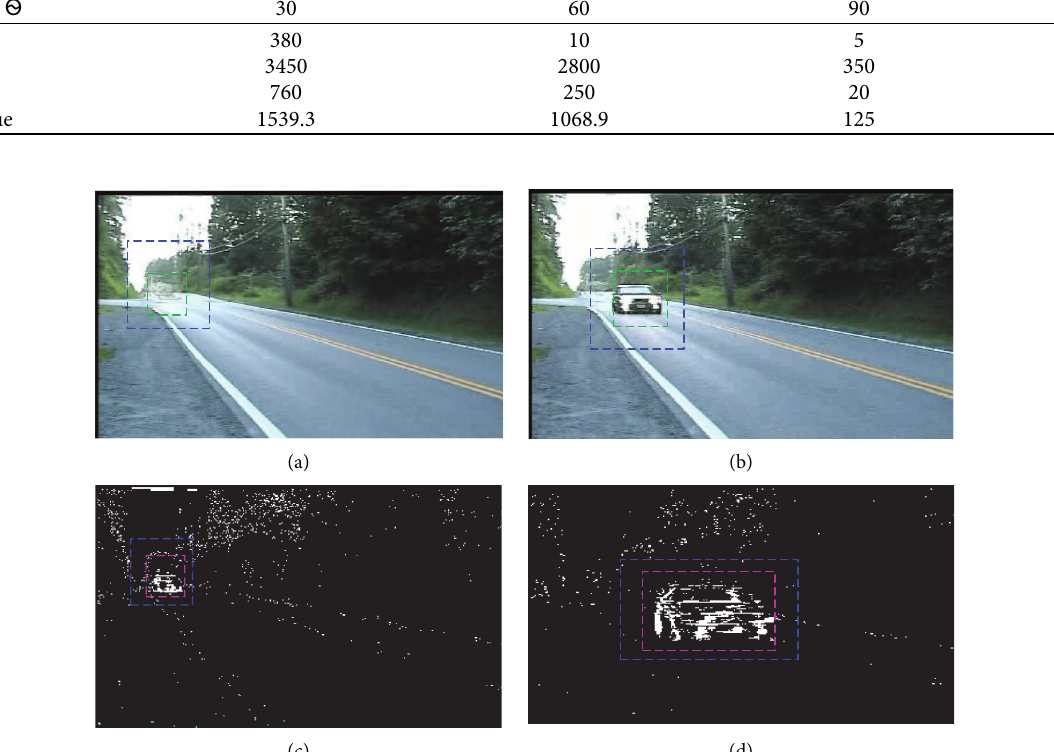
Figure 7: The experiment results of Road scene: (a) background image; (b) frame 50 image; (c) binarised image; (d) background differential binary image.